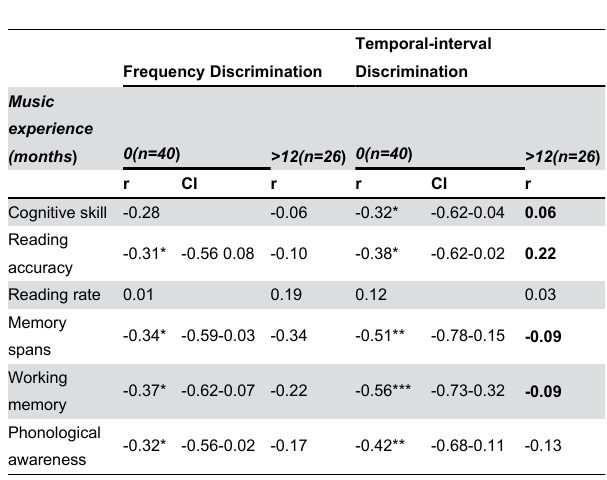
Table 2. Inter skill correlations in the sub-groups with (more than 12 months) and without musical